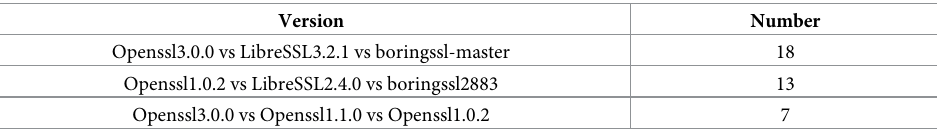
Table 3. The total number of discrepancies for the three